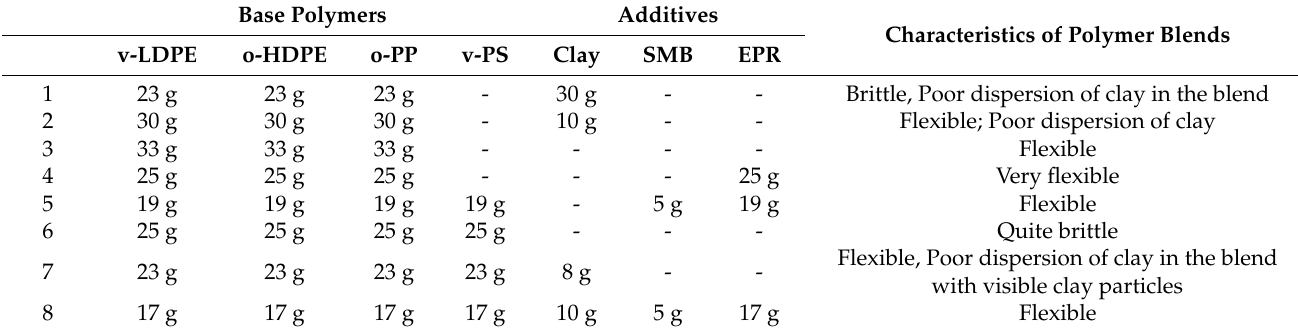
Table 1. Polymer blends prepared by using virgin LDPE (v-LDPE) and PS (v-PS), ocean-bound HDPE (o-HDPE) and PP (o-PP), as well as additives (clay, SMB, and EPR). Base